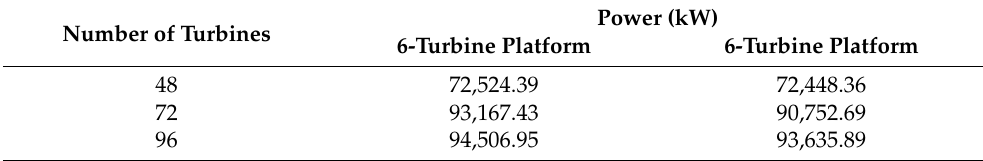
Figure 9. Iteration history of the optimization for 12 six-turbine platforms. 5. Conclusions In the present work, a methodology is proposed to optimize the wind farm layout aiming at maximizing the power production, by considering the wake effects based on the full-field wake model and implementing the improved RS algorithm. The number of wind turbines in the optimized wind farm can be fixed or variable within a range. The initial layout, including a random layout or a uniform layout generated automatically, or a specified layout, which must match the constraint conditions, are all allowable. The present methodology is applied to an offshore floating wind farm composed of novel structural modules. The analyses demonstrate the outperformance of the method- ology, and the efficiency of the improved RS algorithm is also validated. The methodol- ogy presents the ability to optimize the layout of modular wind farms, even a crowded layout, with low computational cost. The introduced scale factor significantly improves the applicability and efficiency of the RS algorithm, especially for high-density layouts.